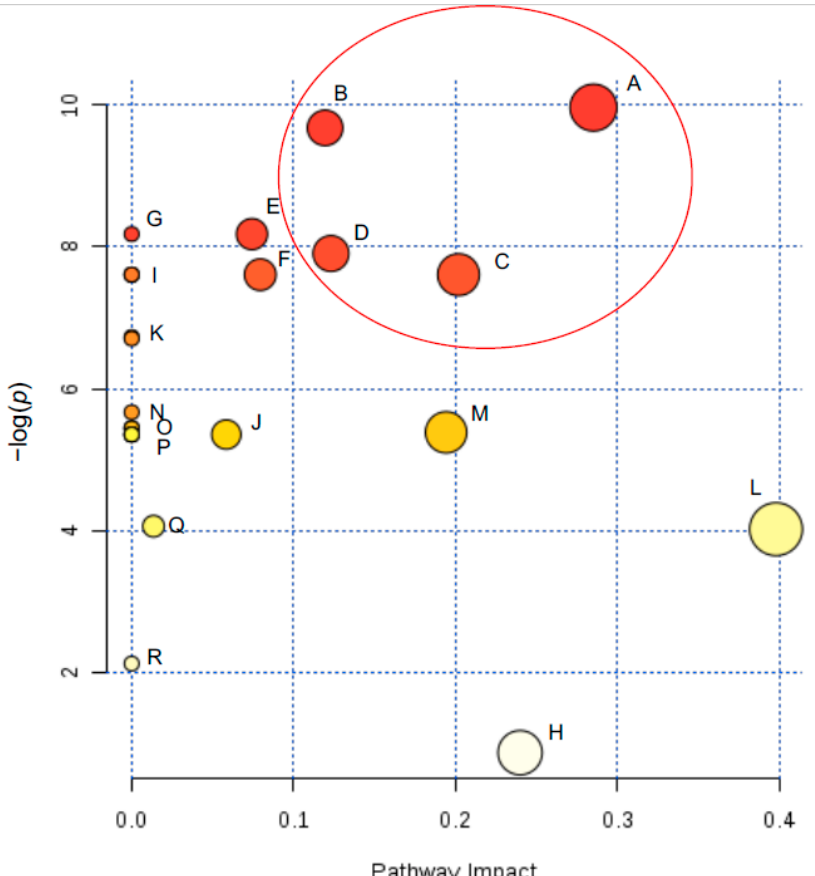
Figure 3. Pathway graph of top 15 VIP scored metabolites according to the p values from the pathway enrichment analysis and pathway impact values from the pathway topology analysis. The color of the circle represents the p -values (red being higher) and the radius of the circle represents impact (where larger radius is higher impact). The four pathways with highest − log( p ) and impact value are circled in red. [A] Glycerolipid metabolism, [B] Glyoxylate and dicarboxylate metabolism, [C] Glycine, serine and threonine metabolism, [D] Citrate cycle (TCA cycle), [E] Glutathione metabolism, [F] Methane metabolism, [G] Aminoacyl-tRNA biosynthesis, [H] Pentose phosphate pathway, [I] Cyanoamino acid metabolism, Thiamine metabolism, Porphyrin and chlorophyll metabolism, [J] Sulfur metabolism, [K] Steroid biosynthesis, Amino sugar and nucleotide sugar metabolism, [L] Starch and sucrose metabolism, [M] Alanine, aspartate and glutamate metabolism, [N] Biosynthesis of unsaturated fatty acids, [O] Arginine biosynthesis, Pyrimidine metabolism, Nitrogen metabolism Amino sugar and nucleotide sugar metabolism., [P] Tyrosine metabolism, Propanoate metabolism, Butanoate metabolism, Nicotinate and nicotinamide metabolism, Fructose and mannose metabo- lism, [Q] Purine metabolism, [R] Galactose metabolism.